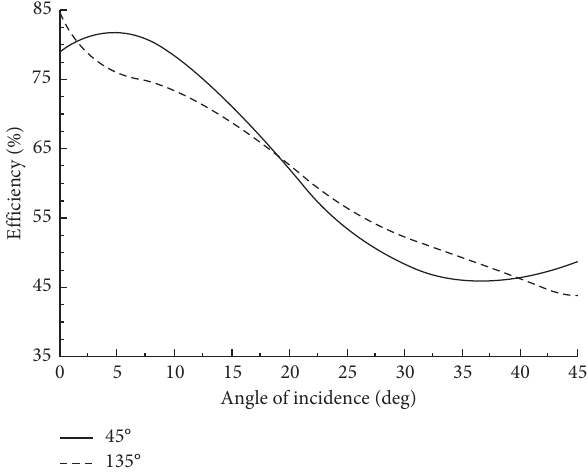
Figure 13: AE Int in the active layer as function of ( d , a ).